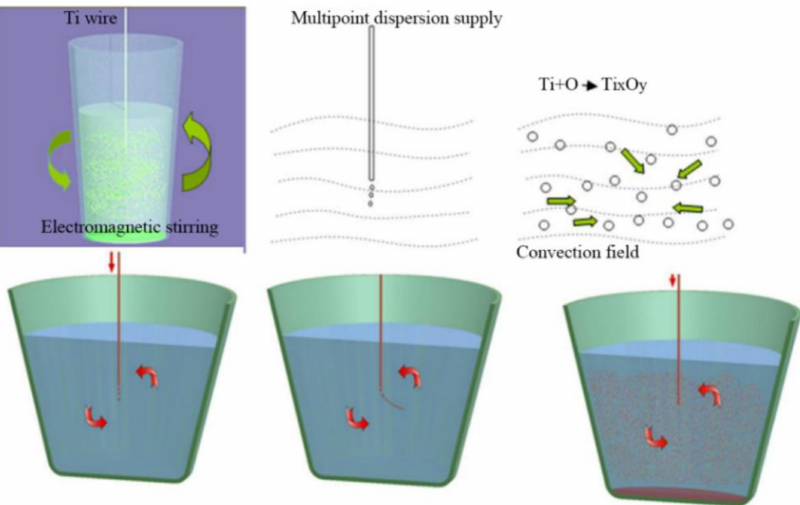
Figure 4. Schematic diagram of the processing method for the formation of nanoparticles in melt through a combination of multipoint dispersion supply processing (unique addition method of Ti wires) and electromagnetic stirring (strong convection stirring)